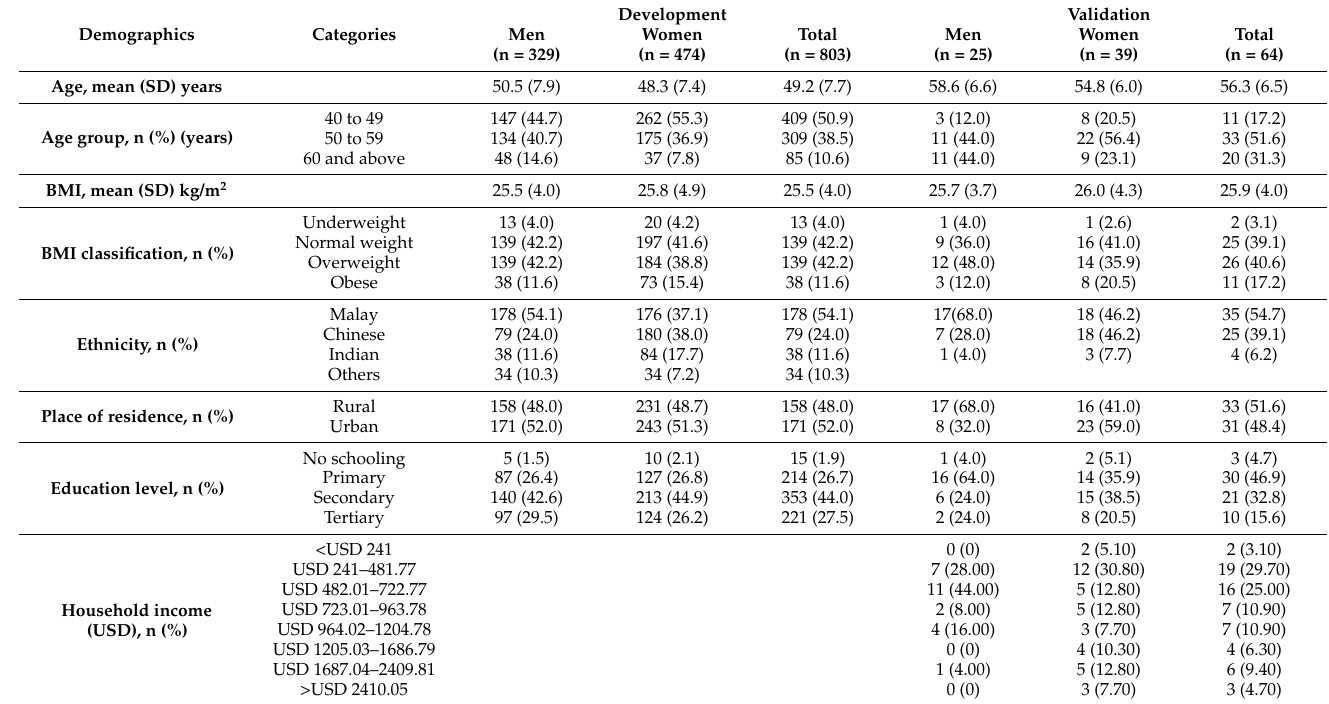
Table 1. Demographic characteristics of subjects from development (n = 803) and validation phase (n = 64).